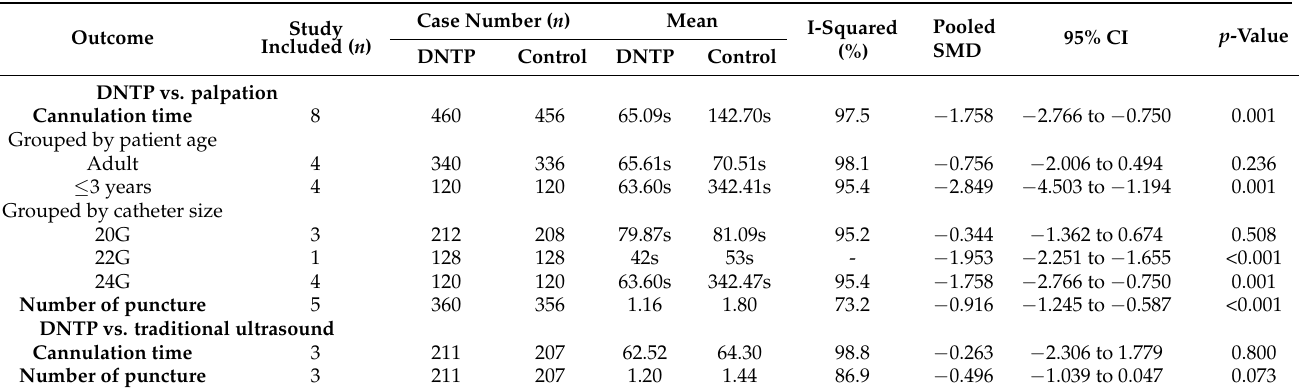
Table 3. Main results of meta-analysis in arterial catheterization practice of DNTP vs. palpation or traditional ultrasound approach.